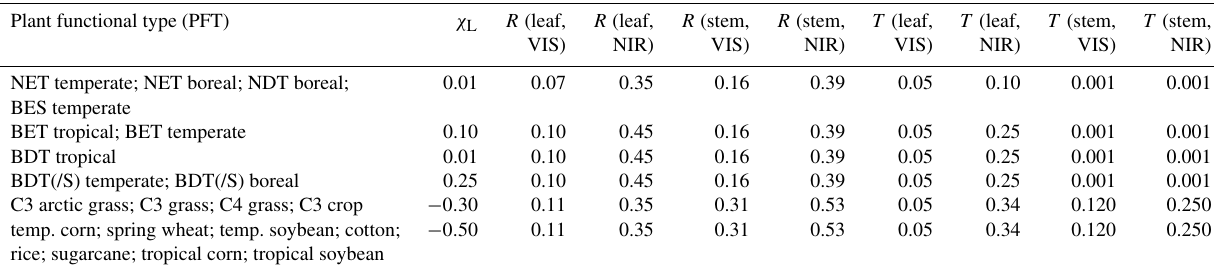
Table 1. Collapsed version of the CLM5 optical properties table in the CLM5 (2018) manual (Table 2.8). Note that in the CLM the leaf angle value ( χ L ) is quantified based on divergence from spherical distribution: 1 = planophile, − 1 = erectophile, and 0 = spherical. Reflectance ( R) and transmittance ( T ) in VIS ( < = 700nm) and in NIR ( > = 701nm). “BDT(/S)” contains both BDT and BDS PFTs for temperate and boreal PFTs.